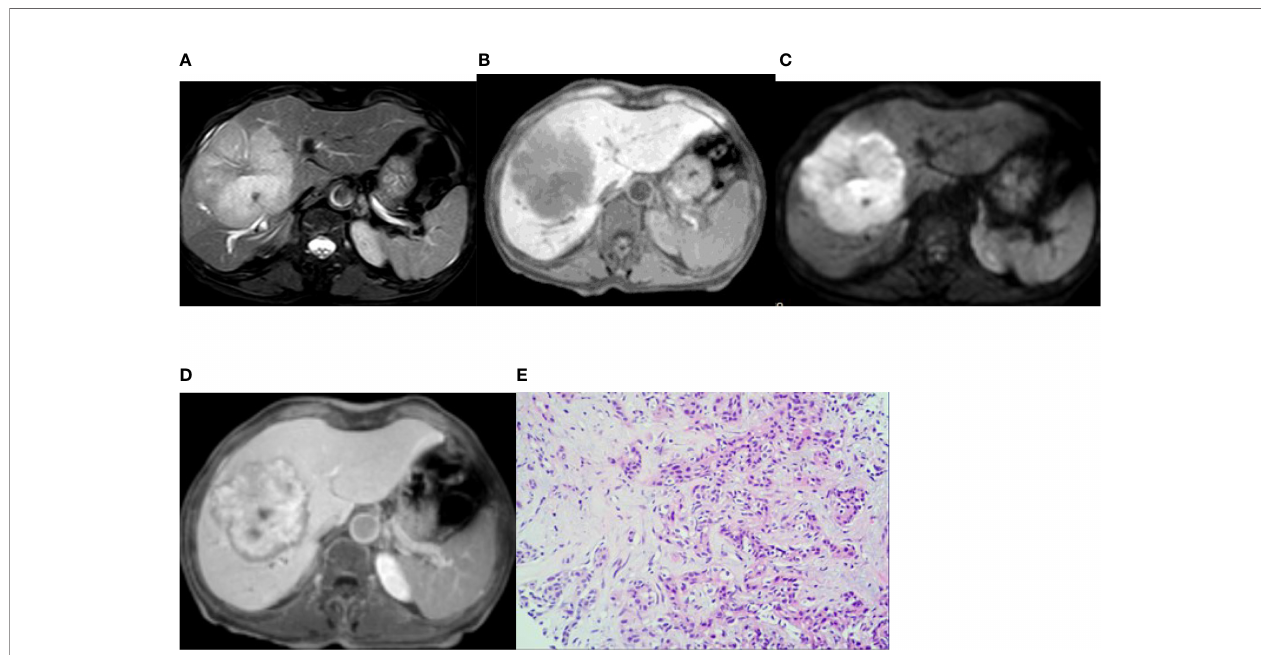
FIGURE 2 | Imaging of intrahepatic mass-forming cholangiocarcinoma. A 66-year-old woman had cholangiocarcinoma with fatigue, no obvious cause of poor appetite, and laboratory examination of CA19-9 13455 U/mL. (A, B) (T2WI and T1WI) showed a lobulated mass with a long T1 and slightly longer T2 signal with clear boundaries. (C) The lesion showed a peripheral relatively high signal on DWI image. (D) On the hepatobiliary-phase enhanced imaging, the peripheral signal was low, whereas the central signal was high. The │ CNR │ was 34.92 in the peripheral region but 20.94 in the central. The visibility score was 5. (E) Pathological sections showed heterogeneous epithelial cells in the fi brous tissues, some of which were glandular and in cords, with mucinous degeneration in the interstitial fi brous tissues. The pathologic diagnosis was cholangiocarcinoma (medium – poorly